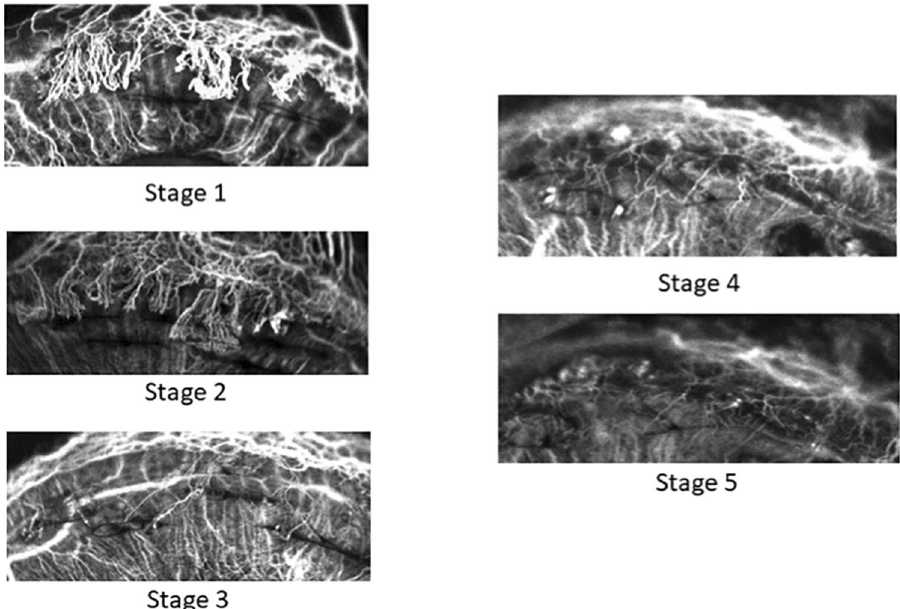
Figure 1. Corneal vascularisation staging determined using indocyanine green angiography 19 . Stage 1: Active young vessels that are newly formed and progressing with a well-defined fine capillary network; signs of leakage and oedema are seen in the surrounding corneal stroma. Stage 2: Active old vessels which appear less bright and reach the lesion but not progressing. Stage 3: Partially regressed vessels with slow blood circulation and are of reduced visibility. Stage 4: Mature vessels that are relatively large with minimal arborisation and regressed or absent capillary networks. Stage 5: Regressed vessels that are very fine white lines mirroring the morphology of the original vessels (ghost